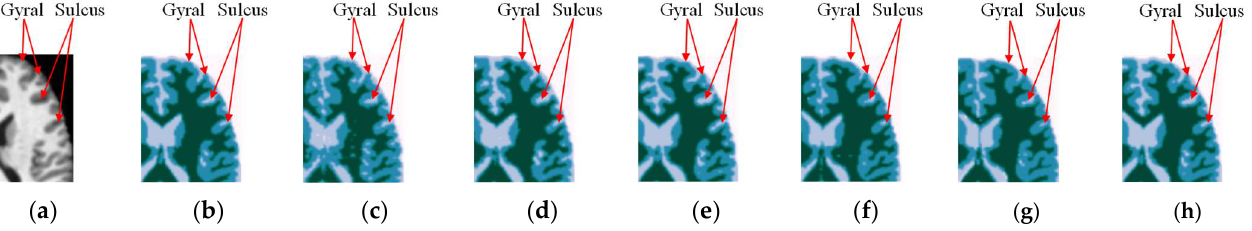
Figure 9. Simplified inner cortical surfaces illustrating gyral and sulcus regions of the brain MRI. ( a ) Original input images, ( b ) ground-truth segmentation maps, ( c ) predicted segmentation map of SegNet, ( d ) predicted segmentation map of U-net, ( e ) predicted segmentation map of M-net, ( f ) pre- dicted segmentation map of U-net++, ( g ) predicted segmentation map of CE-net and ( h ) predicted segmentation map of the proposed method.